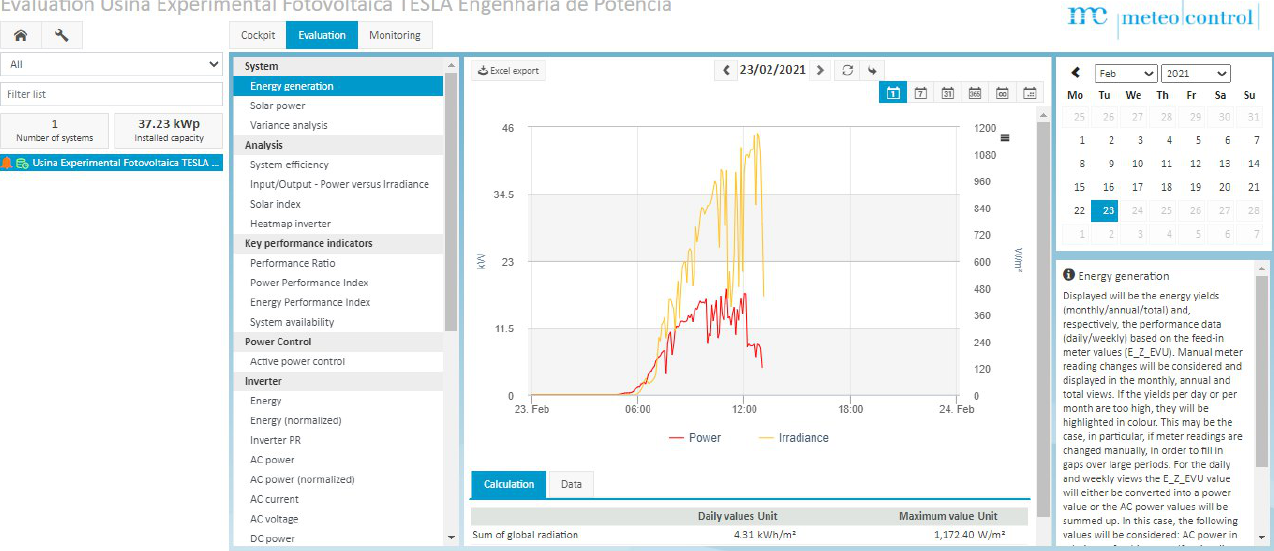
Figure 14. Graphs page of the current supervisory system.